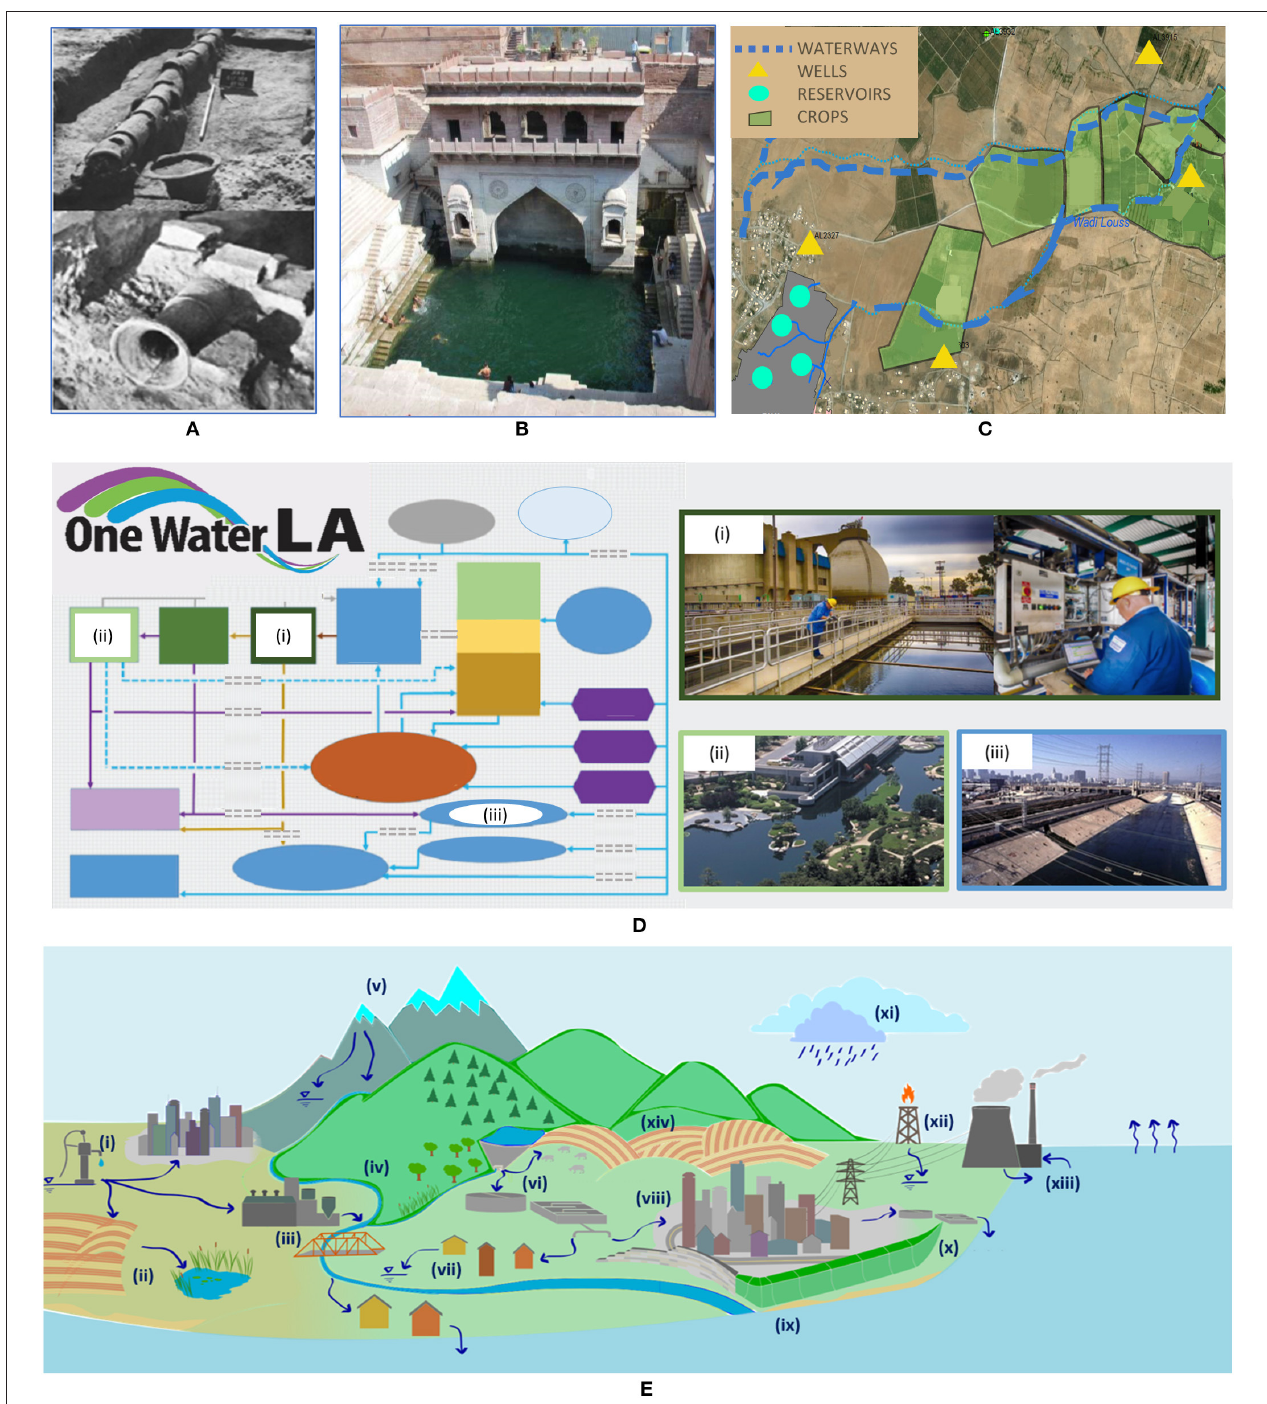
FIGURE 1 | Water infrastructure through millennia with lessons learned for modern times. The evolution of water and built environment throughout human history, along with current and anticipated changes in both the water cycle across scales as well as the coupled natural-engineered-human systems, can offer perspectives relevant to the design and operations of infrastructures related to water. The top layer shows sewerage pipes in ancient (4th to 3rd century BCE) Mesopotamia (Antoniou et al., 2016; figure courtesy, Andreas Angelakis and Saifullah Khan) (A) , the stepwell of Toorji ( Toorji ka Jhalra ) built in 1740 CE by the Queen of Jodhpur, Rajasthan, India (photo courtesy, Udit Bhatia) (B) and the rainfall-runoff water harvesting and storage systems constructed by Nabateans and Romans and maintained from the 1st to the 21st century CE in the Umm el-Jimal archaeological site near Mafraq, Jordan which sustained the sedentary and nomadic populations of the region